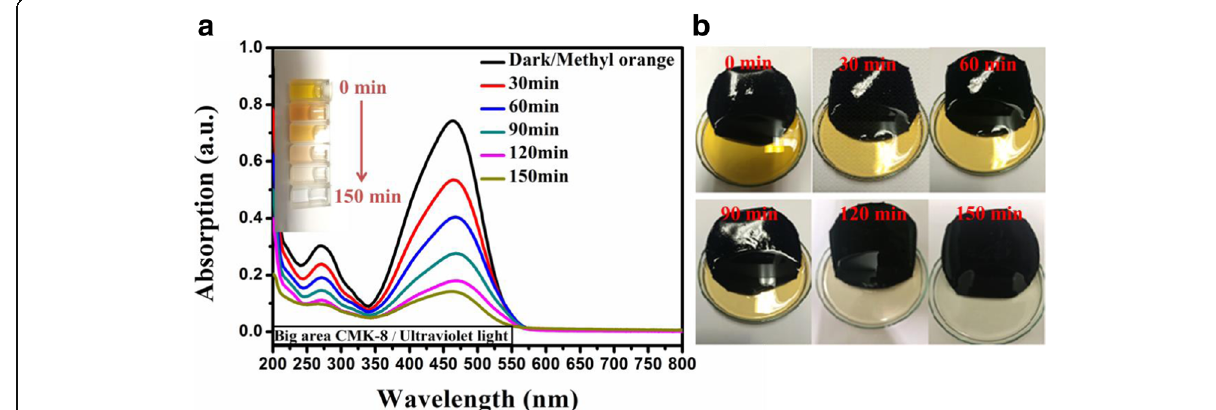
Fig. 4 A free-standing 4-in. CMK-8-Nafion membrane. a UV-Vis spectrum evolution of MO decomposition. b Photographs of MO decoloration under UV irradiation at 254